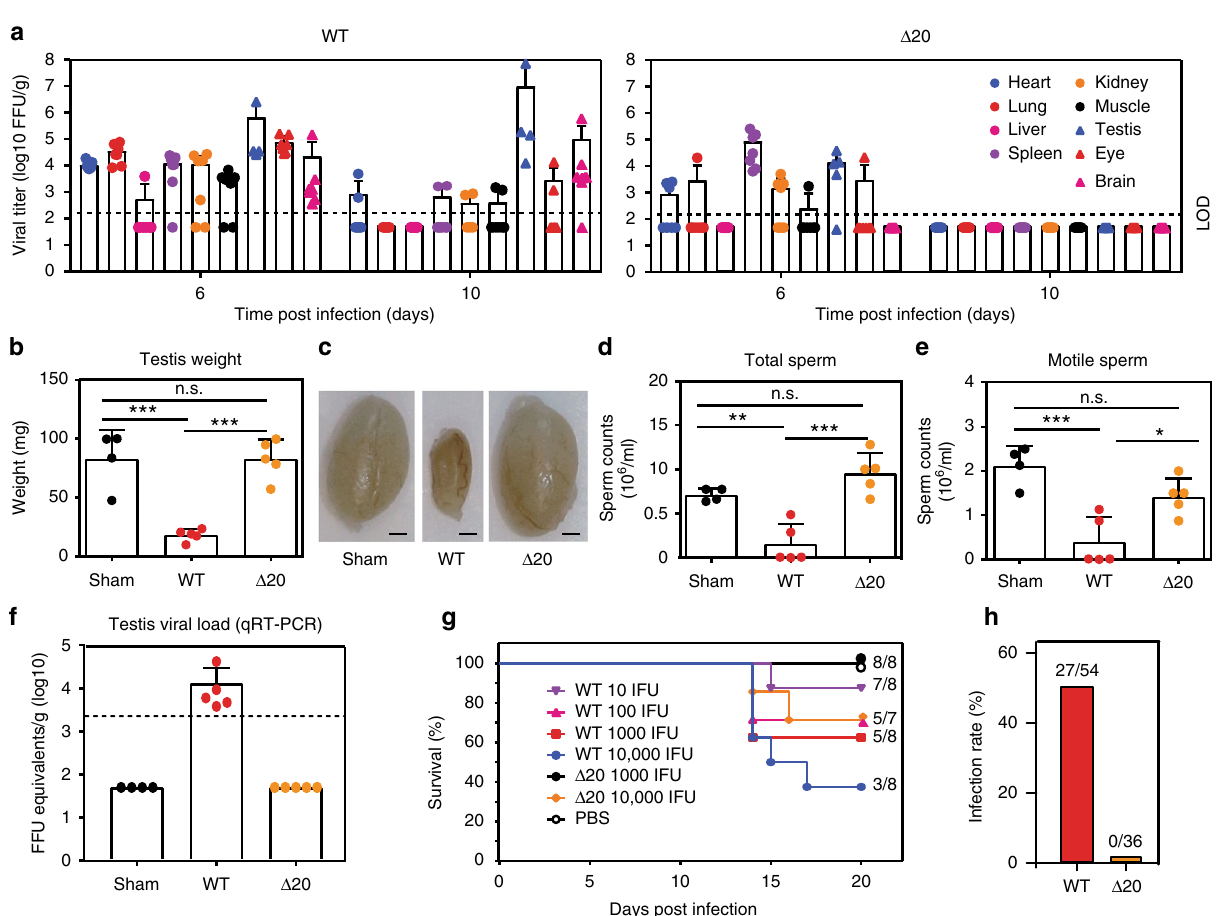
Fig. 4 Safety evaluation of ZIKV-3 ′ UTR- Δ 20-LAV ( Δ 20) vaccine candidate. a Viral loads in organs of infected A129 mice. Three-week-old A129 mice ( n = 7) were subcutaneously immunized with 10 3 FFU of WT ZIKV FSS13025 ( left panel ) and its derivative Δ 20 vaccine candidate ( right panel ). Organs from infected mice were collected and homogenized at days 6 and 10 post infection. The amounts of viruses were quanti fi ed on Vero cells using a focus-forming assay. The mean results from seven animals are presented. Bars denote standard errors. The dashed lines indicate the limit of detection (LOD) of the assay. b – f Effect of Δ 20 vaccination on the testis. Three-week-old A129 mice ( n = 5) were subcutaneously infected with 1 × 10 3 FFU of WT ZIKV FSS13025 or Δ 20 vaccine candidate. At day 28 post infection, animals from each group were analyzed for testis weight ( b ), testis size ( c ), total sperm counts ( d ), motile sperm counts ( e ), and viral RNA load ( f ). Scale bar , 1 mm. g Comparison of neurovirulence of WT ZIKV FSS13025 and Δ 20 vaccine candidate in outbred CD-1 mice. One-day-old CD-1 mice ( n = 7 – 8/group) were injected intracranially with 10 – 10 4 FFU of WT ZIKV or 10 3 – 10 4 FFU of Δ 20 vaccine candidate. Surviving mice and total infected animals are indicated. h Analysis of vector competency. Aedes aegypti were fed on arti fi cial blood-meals spiked with 10 6 FFU/ml of WT ZIKV FSS13025 or Δ 20 vaccine virus. At day 7 post feeding, individual engorged mosquitoes were assayed for infection by immunostaining of viral protein expression on inoculated Vero cells. The number of infected mosquitos and total number of engorged mosquitoes are indicated. Asterisks indicate signi fi cant differences (one-way ANOVA: *** P -value < 0.001; ** P -value < 0.01; * P -value < 0.05). Nonsigni fi cant (n.s.) with P -value > 0.05. All negative samples are plotted at the half value of LOD. Error bars represent